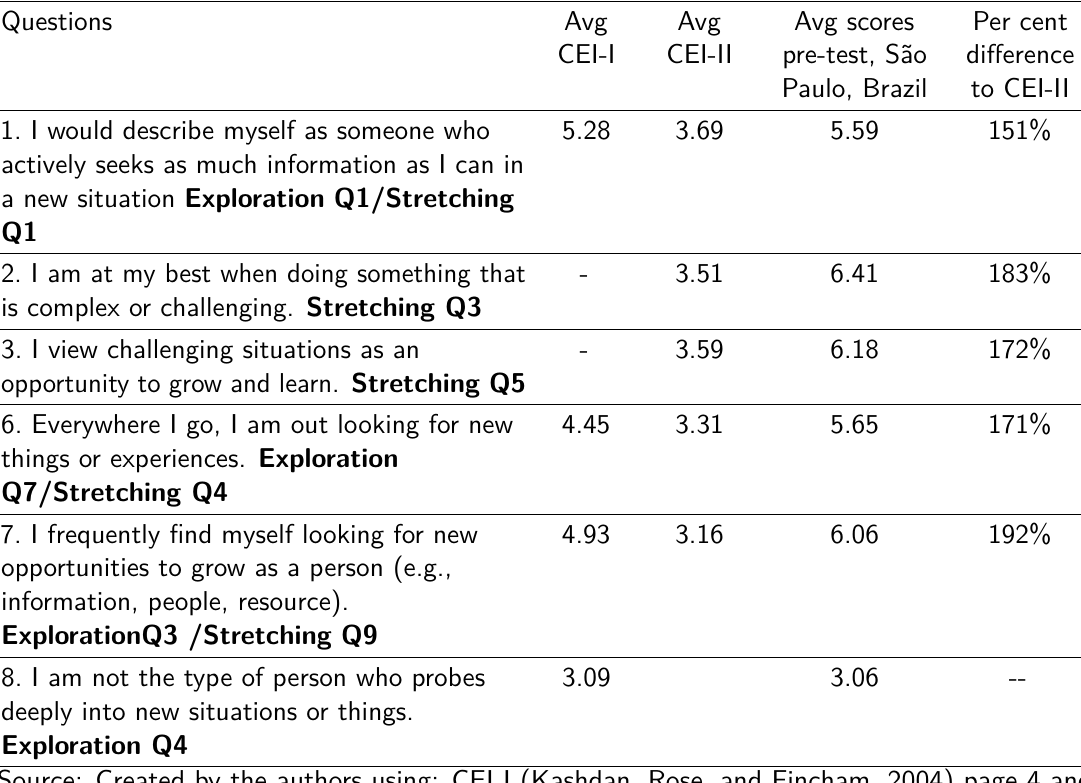
Table 2. Comparison of mean CEI I and II scores with pre-test Questions